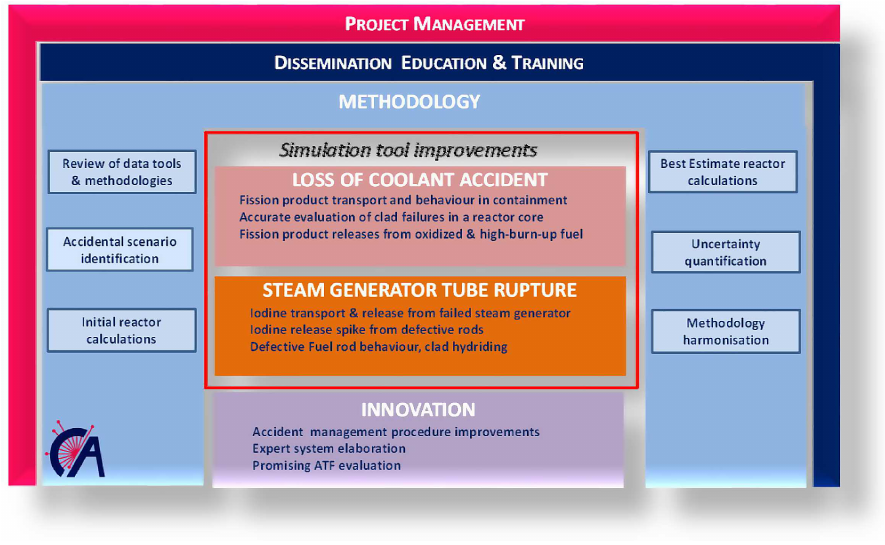
Fig. 5. R2CA overall